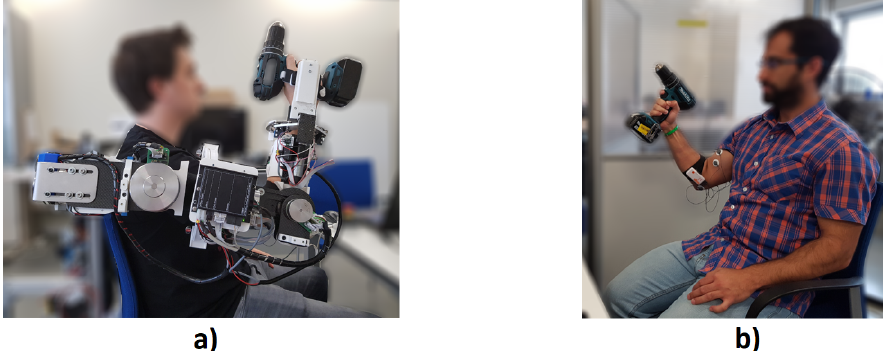
Figure 8. ( a ) Task without the upper-limb exoskeleton. ( b ) Task with the upper-limb exoskeleton. All the participants that appear in the figure have provided written and informed consent for its